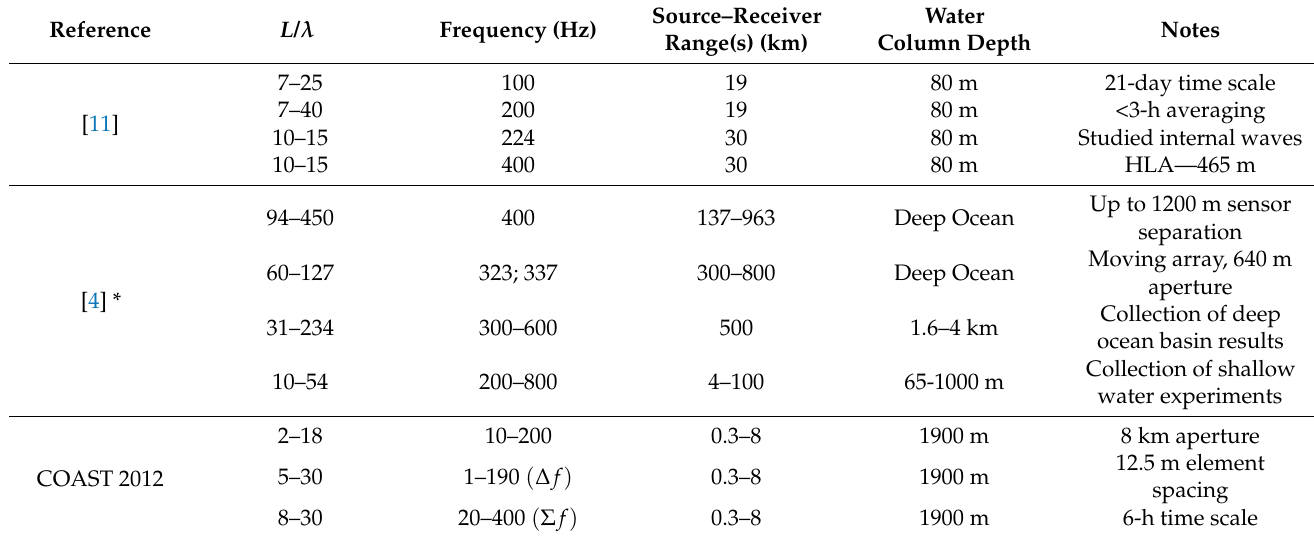
Table 1. Summary of coherence lengths from a collection of other